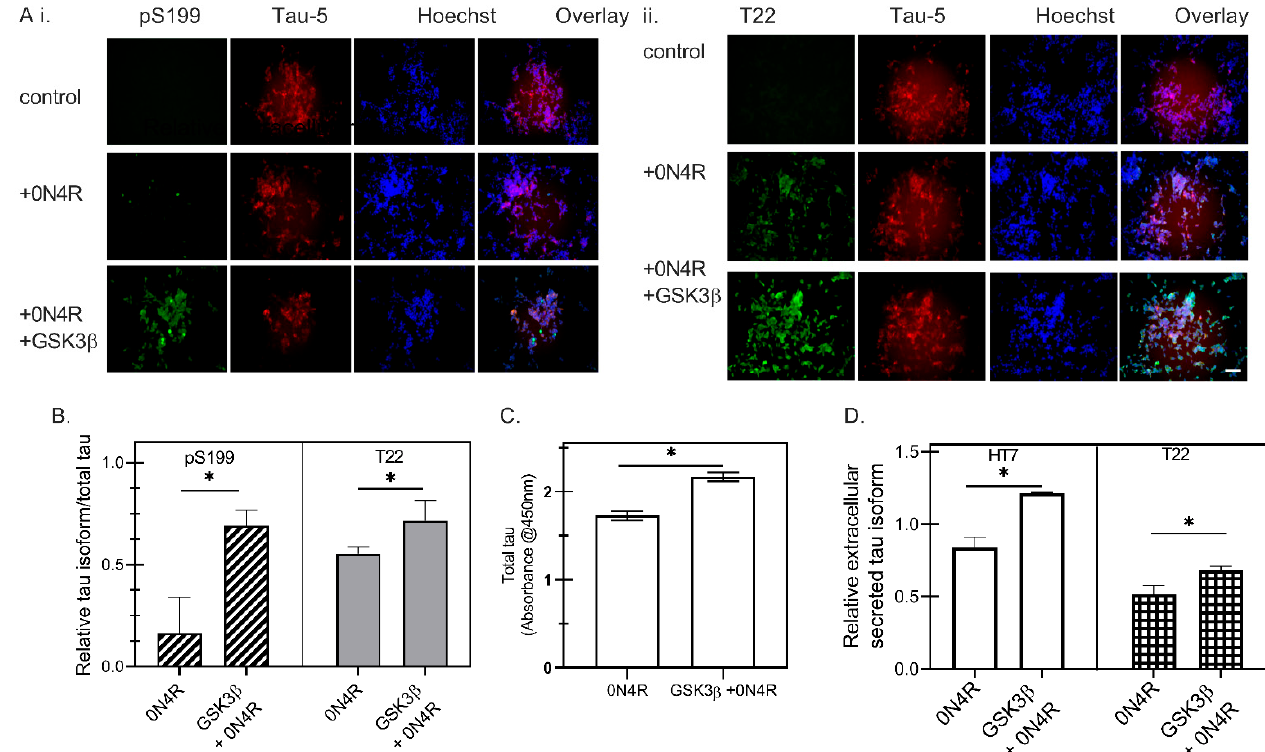
Figure 2. The phosphorylation characteristics of PS19 transgenic mice brain extracts. Characterization of SH-SY5Y cells transfected with wild type 0N4R and GSK3 β constructs. Representative fluorescent images of tau markers, including pS199 (Green)/Tau-5 (Red)/Hoechst (Blue) ( A ( i )) and T22(Green)/Tau-5 (Red)/Hoechst (Blue) ( A ( ii )) for SH-SY5Y cells three days post-transfection. Scale bar = 100 µm. ( B ) Quantitative analysis of fluorescence intensity of pS199 (dark gray hatched bars) and T22 (light gray solid bars), normalized to Tau-5+ intensity as a measure of the total tau expression, for SH-SY5Y cells expressing 0N4R tau with GSK3 β co-transfection (GSK3 β + 0N4R) or without GSK3 β (0N4R), where * represents p < 0.05 for n = 3. ( C ) The oligomeric and total tau were measured by sandwich ELISA of SH-SY5Y cell lysates using T22 and human tau antibody, respectively. * p < 0.05 for 0N4R compared with GSK3 β + 0N4R ( n = 3). ( D ) Total tau (open bars) or oligomeric tau (boxes-filled bars) of the conditioned medium were measured by indirect ELISA using HT7 and T22, respectively, to investigate the effects of phosphorylation on tau secretion. (* represents p < 0.05 for 0N4R compared with GSK3 β + 0N4R ( n = 3)).